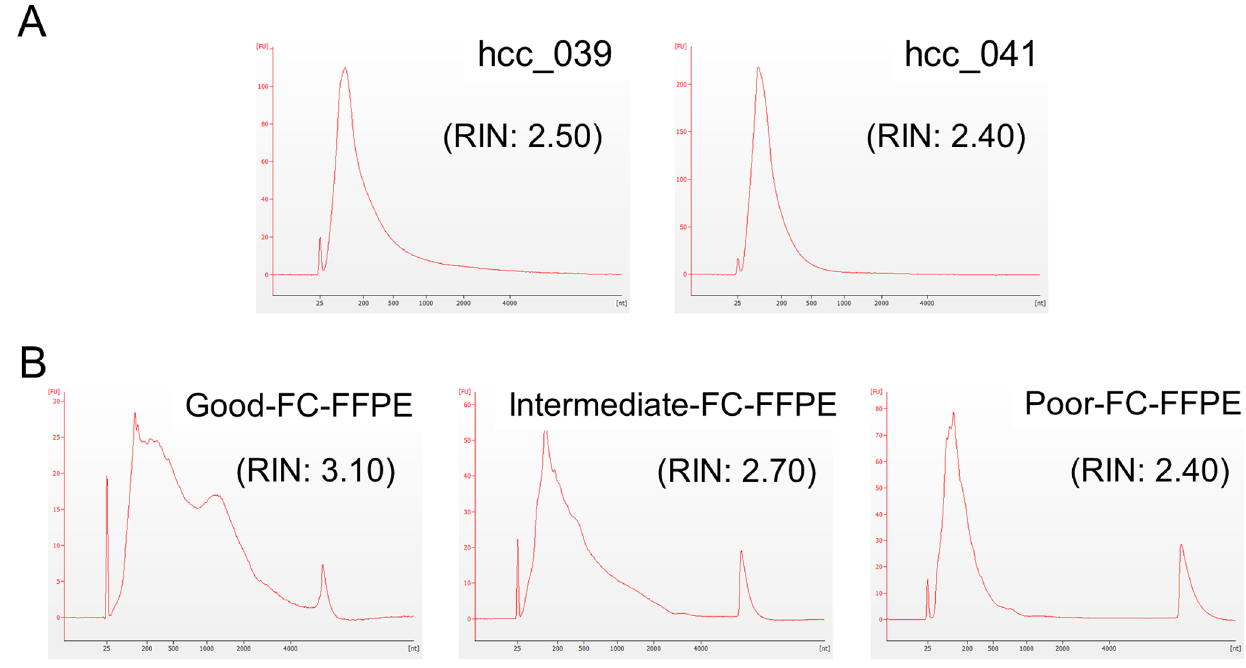
Figure 1. Bioanalyzer results for total RNA isolated from (A) AS-FFPE HCC tissues, and (B) good, intermediate, and poor quality FC- FFPE tissues. The AS- and FC-FFPE RNA samples were extracted from different samples. AS: archived section, FFPE: formalin-fixed paraffin- embedded, HCC: hepatocellular carcinoma, FC: freshly cut, RIN: RNA Integrity Number.